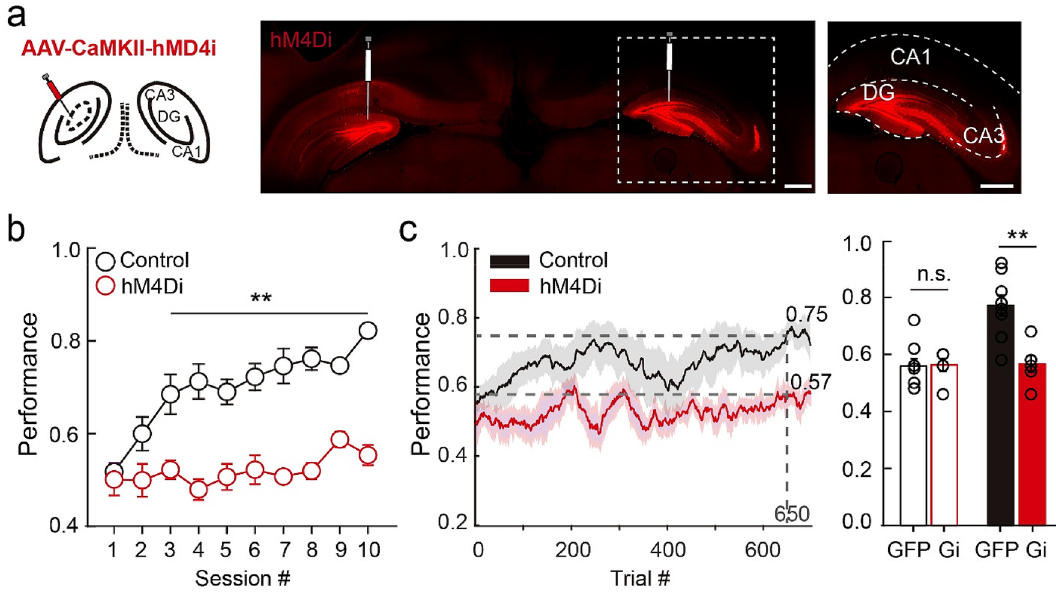
Figure 6. DGC activity is required for learning the auditory task. ( a ) Confocal images of the hippocampus with hm4Di-mCherry expression in the dentate gyrus (scale bar: 1 mm). Right, enlarged image from the white dashed box (scale bar: 1 mm). ( b ) Session performance. Control rats reached ~ 75% accuracy within 10 sessions, whereas hM4Di-injected rats performed at chance level (n = 10 rats for control and n = 6 rats for hM4Di, mean ± SEM, Kruskal–Wallis test, ** P < 0.01). ( c ) Trial performance (in 100-trial sliding window). Control rats reached ~ 75% performance by the 650th trial, whereas the hM4Di-injected rats performed at chance level. Right, average performance in the first 100-trial window and the 650th window (n = 10 rats for control and n = 6 rats for hM4Di, mean ± SEM, Kruskal–Wallis test, n.s., P > 0.05, ** P <